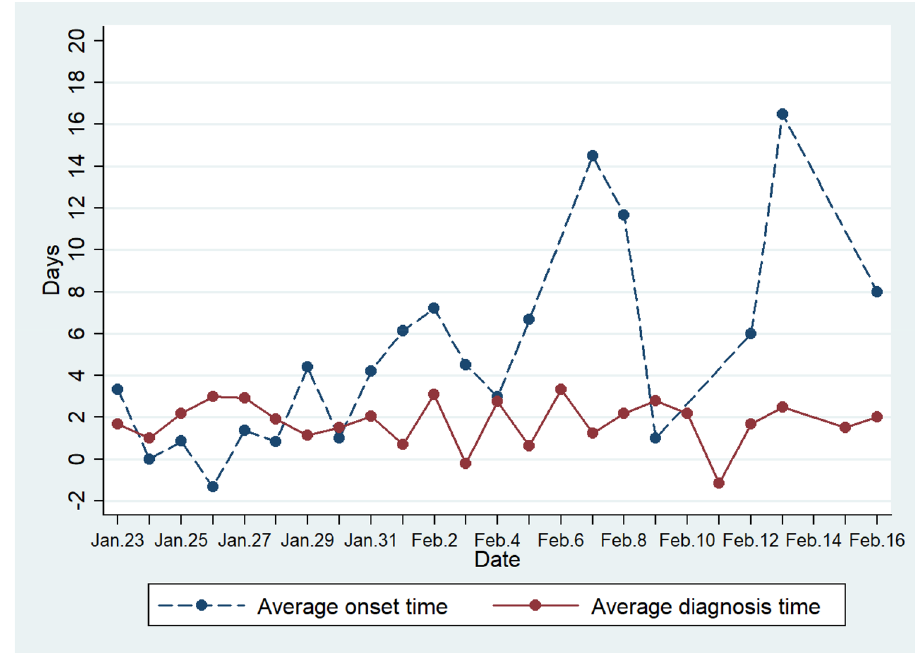
Figure 3. Changes in the average onset and diagnosis time of COVID-19 cases in Shaanxi Province. Average onset time refers to the time when symptoms occur in imported cases after they reach Shaanxi. Average diagnosis time refers to the time taken for all cases to take medical measures after symptoms appear. Both calculations are based on daily published cases.